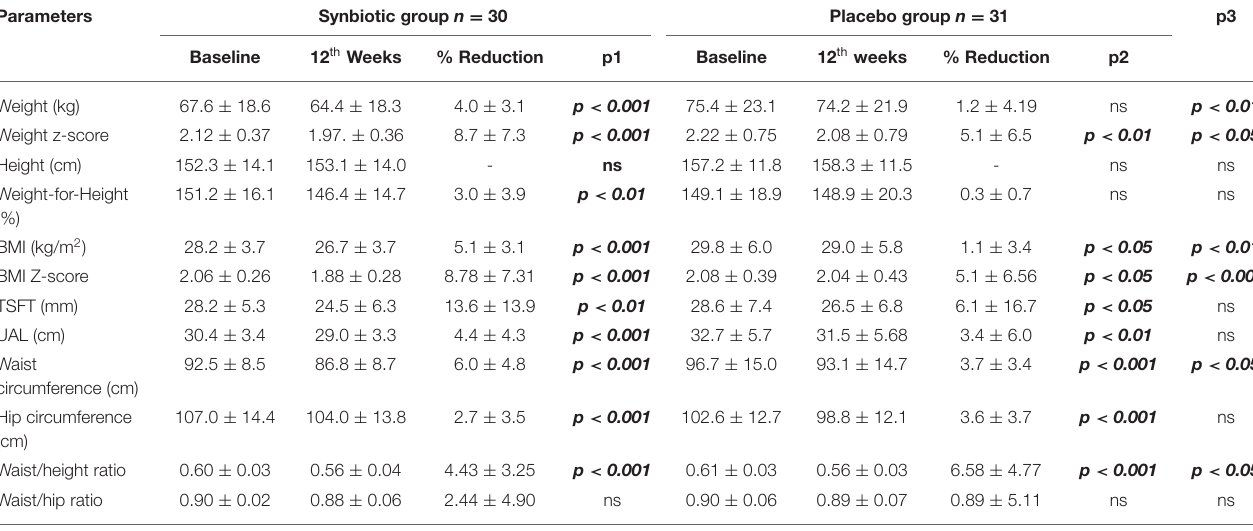
Waist/height ratio